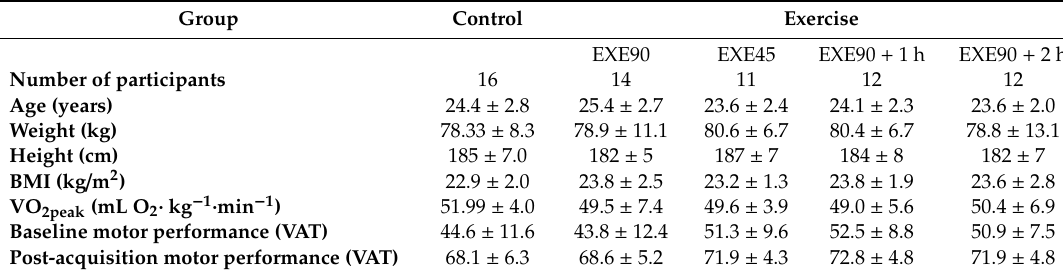
Table A1. Characteristics of study participants, baseline and post-acquisition motor performance VAT = visuomotor accuracy tracking